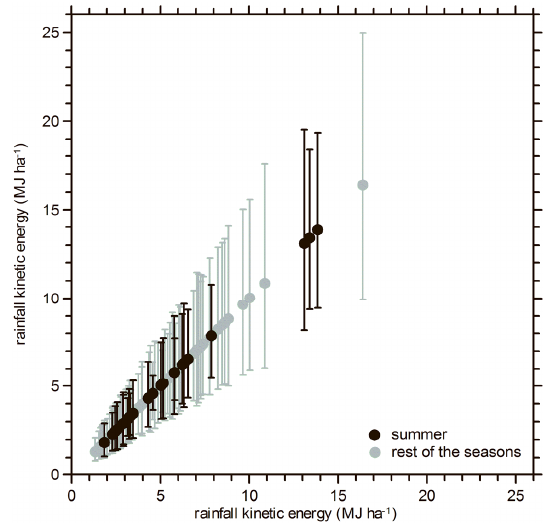
Figure 4. Fig. 4. 90% uncertainty bounds for a set of estimates of event rain- fall kinetic energy at Vallcebre, obtained from rainfall records using Eqs. (4) and